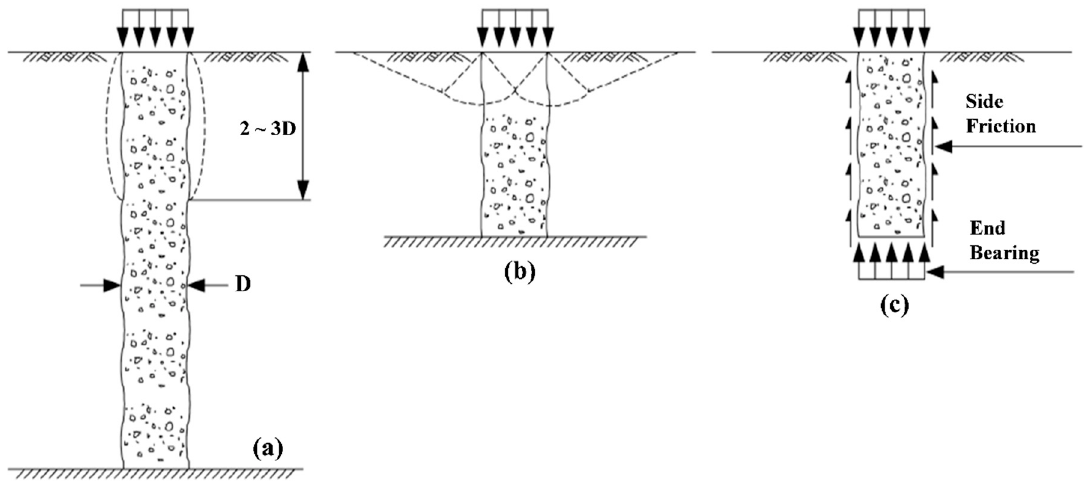
Figure 2. Failure Modes of individual columns: ( a ) bulging failure, ( b ) shear failure, and ( c ) punching failure (after Barkdale and Bachus [6]; Kim and Lee [9]).